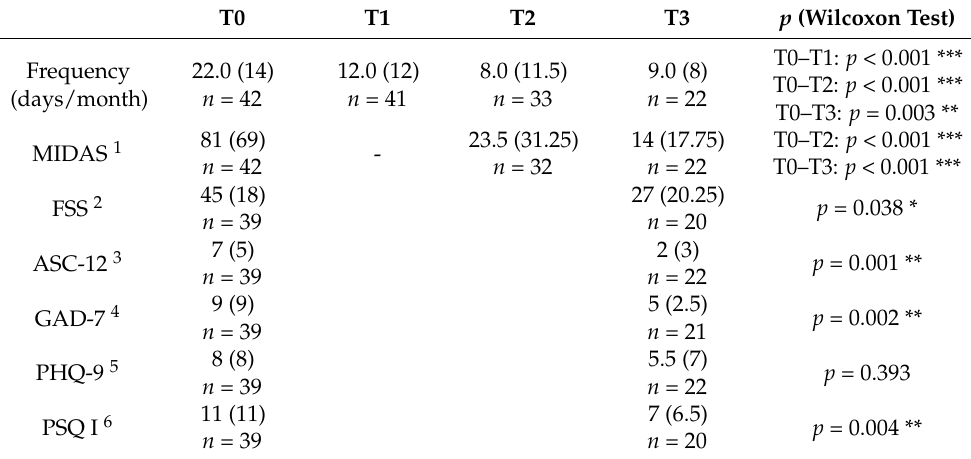
Table 1. Clinical features comparison at different time points. Values are expressed as median (IQR) and the number of patients ( n ).